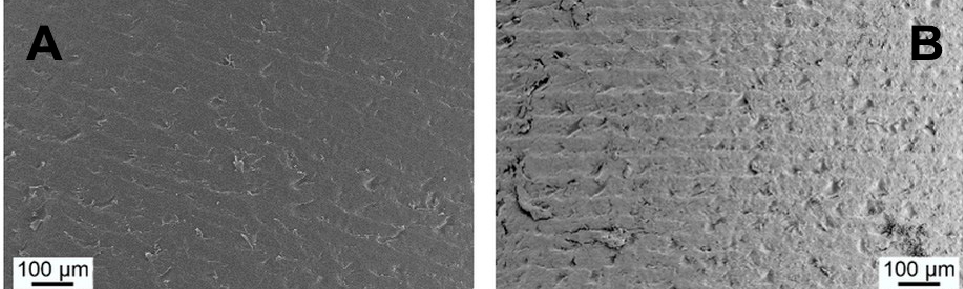
Figure 7. SEM images of the unmodified implant surface (PI) ( A ) post-production and ( B ) after 8 weeks in vivo. Almost no tissue remains on the surface after pull-out test.